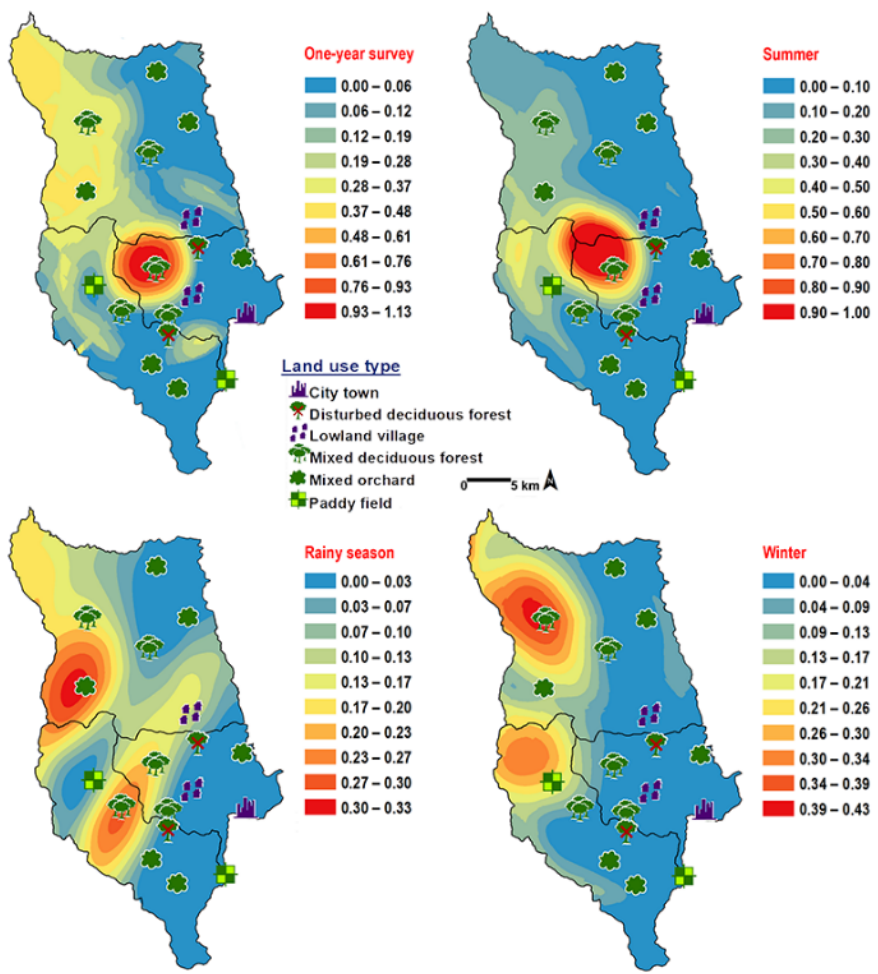
Figure 6. Predictive distribution maps of Chrysomya villeneuvi . The red areas symbolize the highest density of flies calculated by the analysis, while the blue areas indicate the lowest density. The scale corresponds to natural logarithm of (fly density +1).